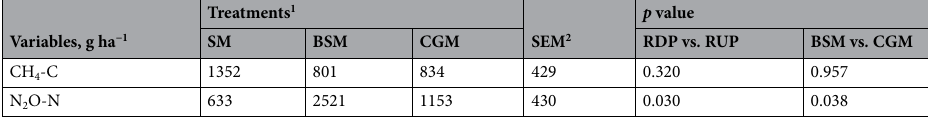
Table 2. Cumulative CH 4 and N 2 O emissions from the manure of Nellore cattle fed with sources of rumen undegradable protein during the finishing phase in feedlots. 1 SM = manure of animals fed soybean meal as a source of rumen degradable protein (RDP), BSM = manure of animals fed by-pass soybean meal as a source of rumen undegradable protein (RUP), CGM = manure of animals fed corn gluten meal as a source of RUP; 2 SEM = standard error of the mean. Chamber considered as an experimental unit (n = 9). The cumulative values refer to 112 days of feedlot.